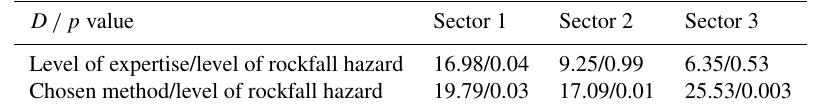
Table 12. Chi-square distance between the observed and theoretical values for all the cases tested, under the hypothesis of